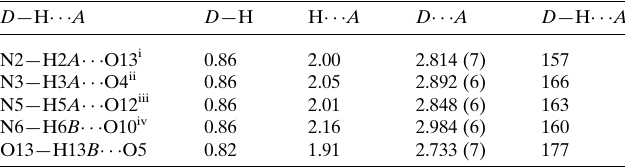
Table 1 Hydrogen-bond geometry (A˚ , (cid:3) ).